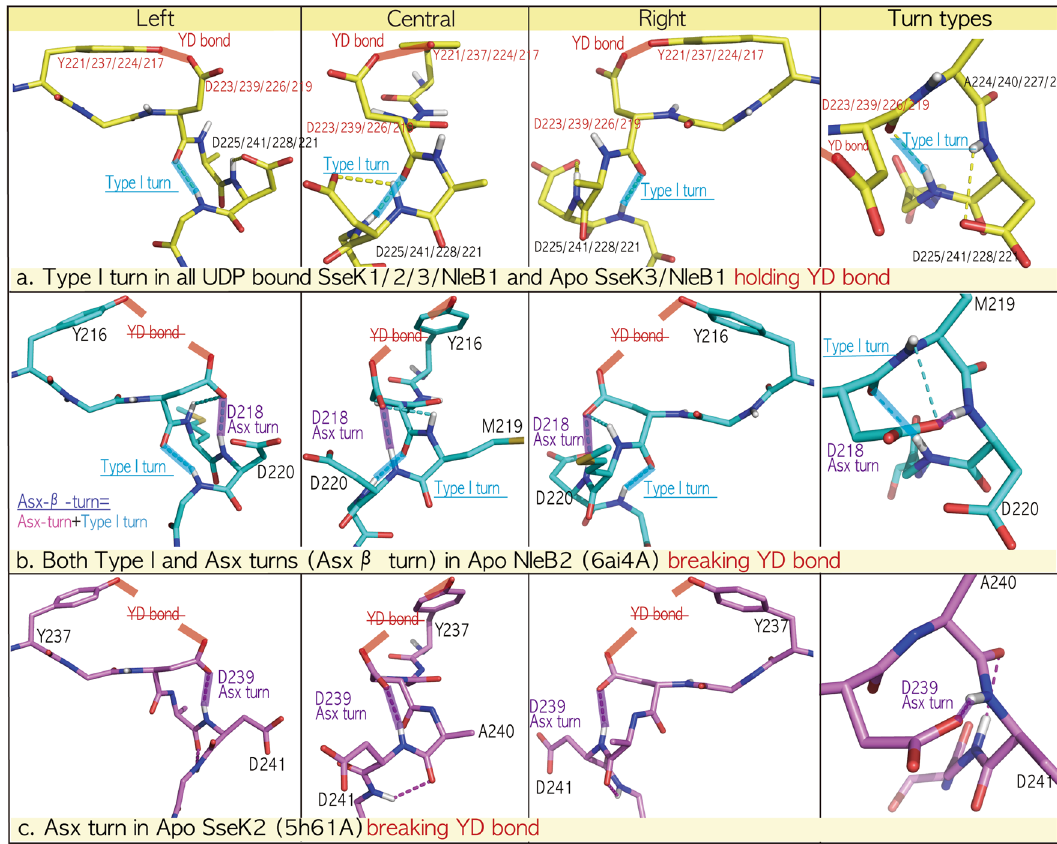
Figure 2. Type-I-turns in fatal NleB1/SseK1/SseK3 vs . the Asx-turn in SseK2/NleB2. ( a ) Type-I-turns in all ligand-bound SseK1/2/3/NleB1 and apo SseK3/NleB1 DxD motifs holding the YD bond. In the ligand-bound complex of all NleB/SseKs orthologs and apo NleB1/SseK1/SseK3 effectors (Table 2), the DxD motif folds to a Type-I-turn (cyan colored), and the sidechain of tyrosine holds the first aspartate side chain, referred to as a YD bond (red colored). ( b ) Both Type I and Asx-turns (Asx β turn) in apo NleB2 (6AI4) break the YD bond. The refined NleB2 DxD motif showed the characteristic Asx β turn, twice intertwined with Type-I-turn (cyan colored) and Asx-turn (purple colored) by two C10 H-bond networks between backbone CO of D218 and NH of M221 and between the side chain of D218 and NH of D220, resulting in breaking the YD bond. ( c ) Asx-turn in apo SseK2 (5H61: < Chain A) breaks the YD bond. In apo SseK2, the DxD motif forms an Asx-turn, by a C10 H-bond network between the side chain of D239 and the backbone NH of D241, resulting in breaking the YD